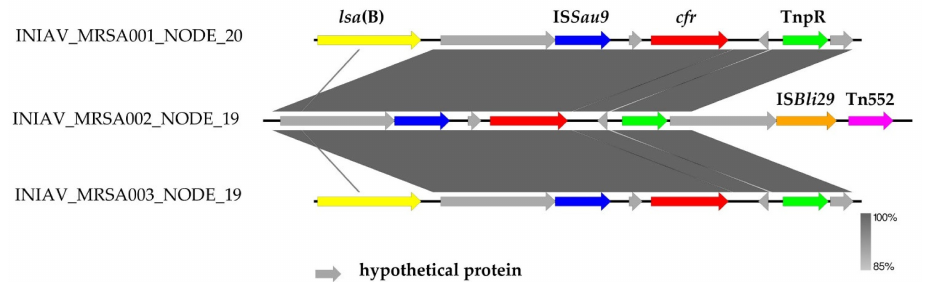
Figure 4. Genetic platforms of the cfr genes in the MRSA isolates determined using EasyFig. This figure represents the genomic environment of the cfr genes, regarding mobilization elements (insertion sequences and transposons) and other antibiotic determinants. The gray area represents the blast identities, and the percentage of identity is indicated in the legend.